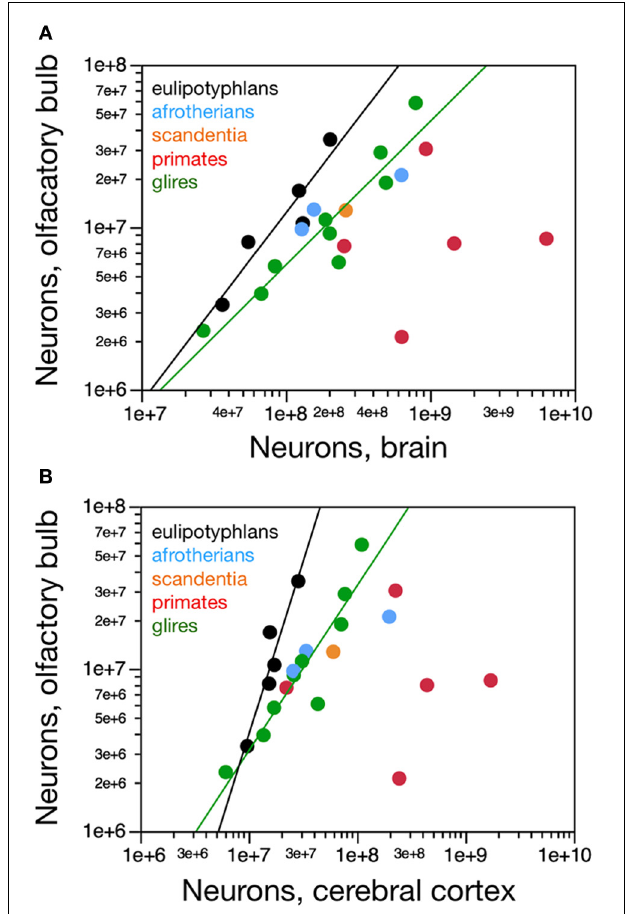
FIGURE 4 | Scaling of numbers of neurons in the olfactory bulb as a function of numbers of neurons in the brain and in the cerebral cortex. (A) The number of neurons in the olfactory bulb increases as power functions of the number of neurons in the whole brain (without the olfactory bulb) of exponent 1.163 ± 0.247 in eulipotyphlans and 0.884 ± 0.122 in glires, respectively, but not in primates. Notice that eulipotyphlans have more neurons in the olfactory bulb than glires and afrotherians for similar numbers of brain neurons. (B) The number of neurons in the olfactory bulb of eulipotyphlans increases at a faster rate than in the cerebral cortex, as a power function of exponent 2.129 ± 0.428, but at the same pace as the cerebral cortex in glires, with an exponent of 1.018 ± 0.148. Notice that eulipotyphlans have more neurons in the olfactory bulb than glires and afrotherians for similar numbers of cortical neurons. There is no significant relationship between numbers of olfactory bulb and cerebral cortical neurons across primate species. Eulipotyphlan data from Sarko et al. (2009). Afrotherian data from Neves et al. (2014). Glires, data from Herculano-Houzel et al. (2011) and this study. Primates and scandentia, data from this study.